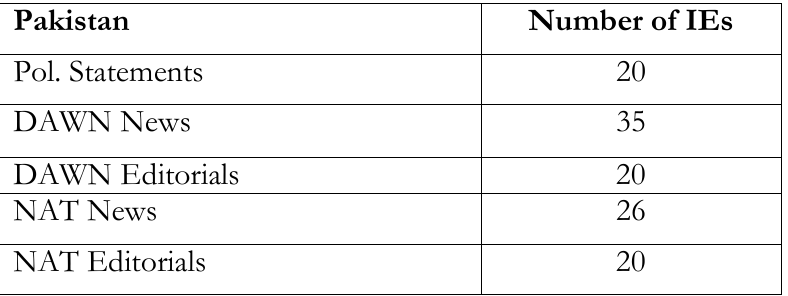
Table 4. Framing samples in the Pakistani political statements and media coverage